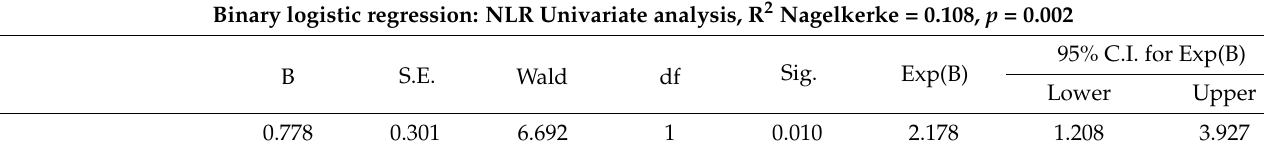
Table 4. Uni and multivariate analysis for NLR and SII